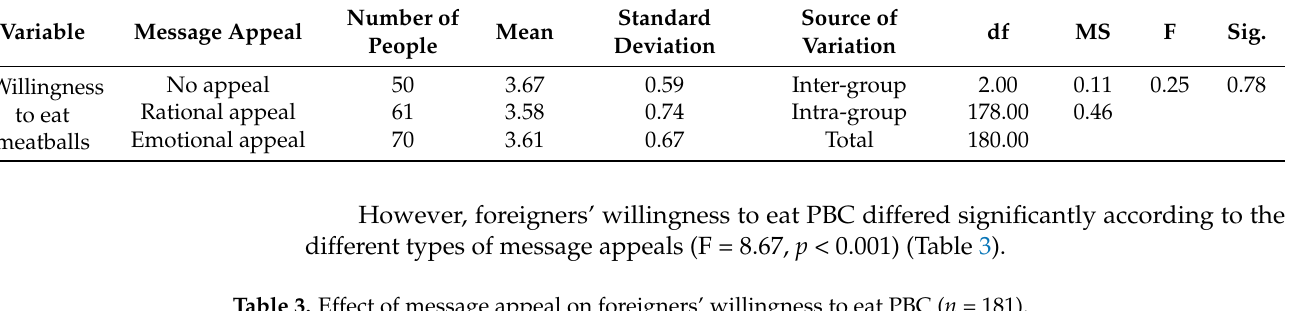
Table 3. Effect of message appeal on foreigners’ willingness to eat PBC ( n = 181).